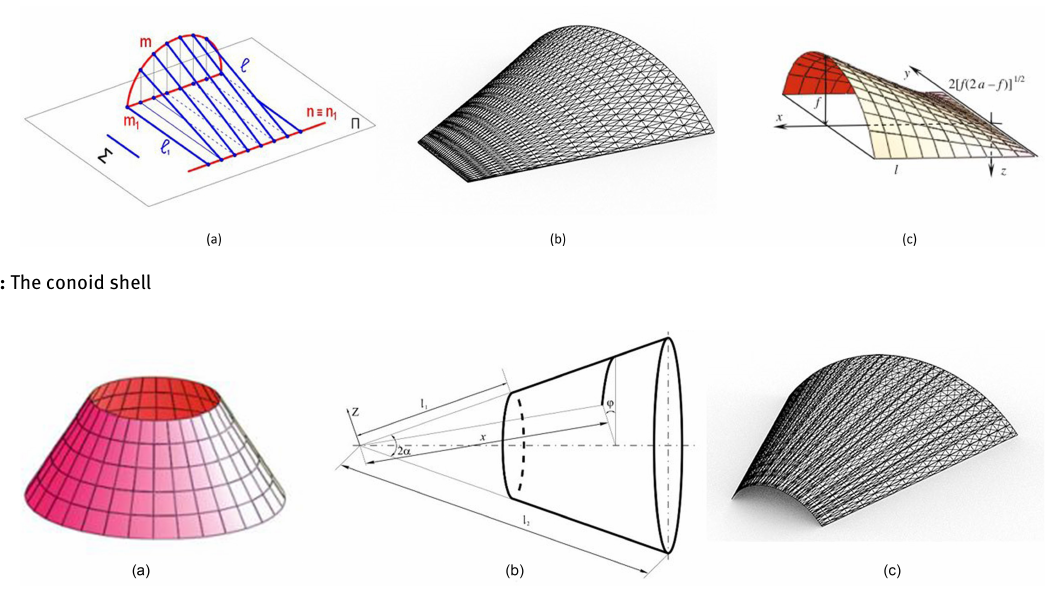
Figure 5: The truncated cone shell